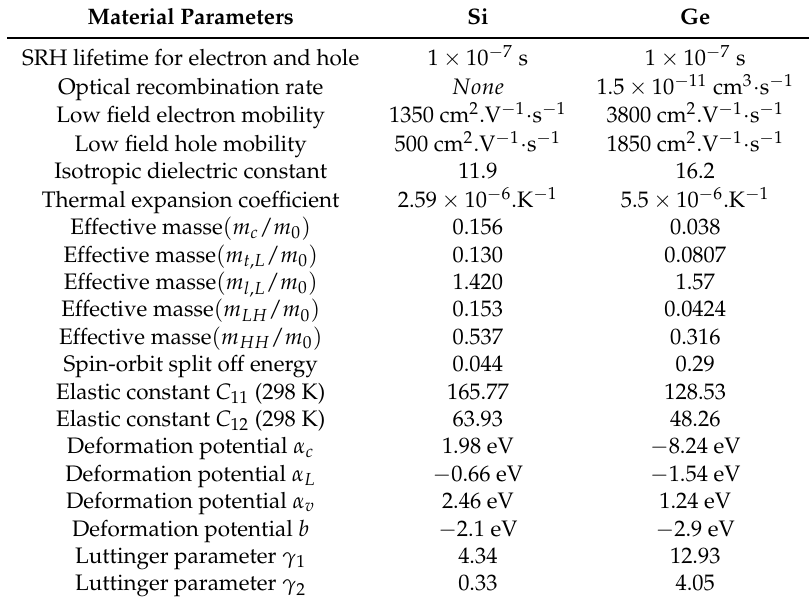
Table 1. Material parameters for bulk Ge and Si at 300 K in our